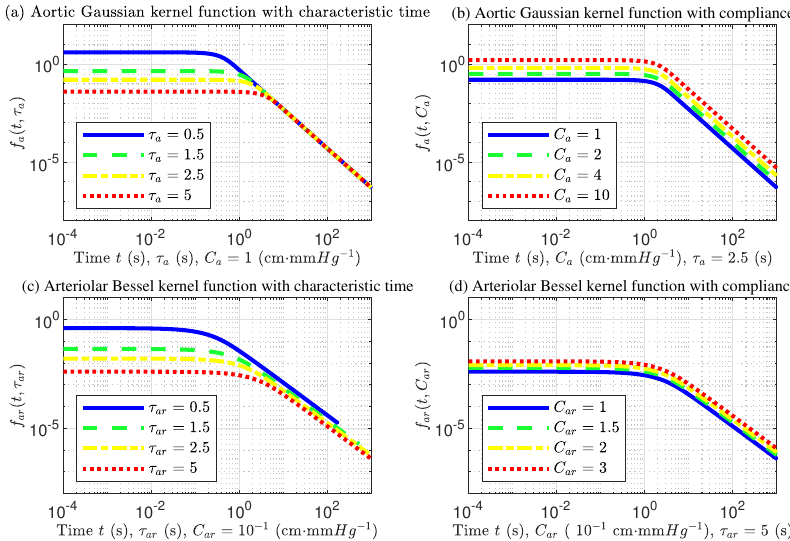
Figure 7. Aortic Gaussian-type kernel function with quadratic quotient (GKF-QQ) and arteriolar Bessel-type kernel function weighted by negative exponential function (BKF-NEF) modulated by different characteristic time and vascular compliance, respectively: ( a ) Aortic GKF-QQ changes with characteristic time; ( b ) Aortic GKF-QQ changes with vascular compliance; ( c ) Arteriolar BKF-NEF changes with characteristic time; ( d ) Arteriolar BKF-NEF changes with vascular